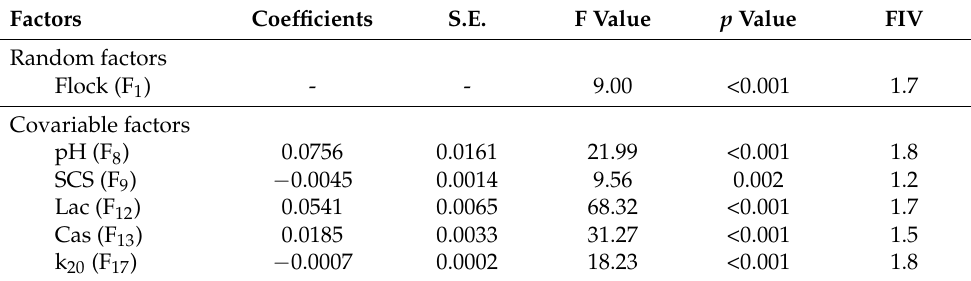
Table 6. Determinants for dry curd efficiency (DCE) according to GLM ( n = 967). Factors Coefficients Random